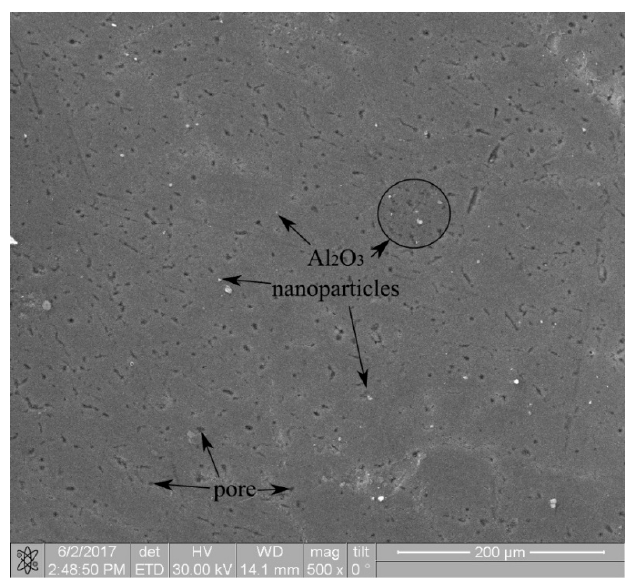
Figure 4. Scanning electron microscopy (SEM) image of the composite AA6082-0.2 wt % Al 2 O 3 after combined rolling.